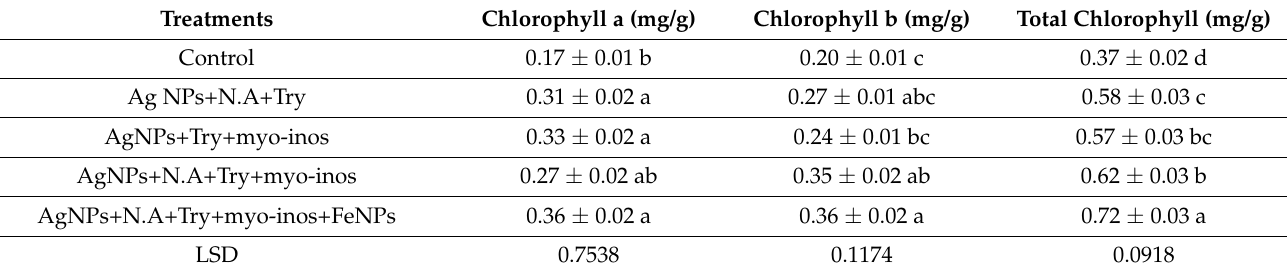
Table 2. Effect of different treatments of blended NPs on chlorophyll contents of wheat.